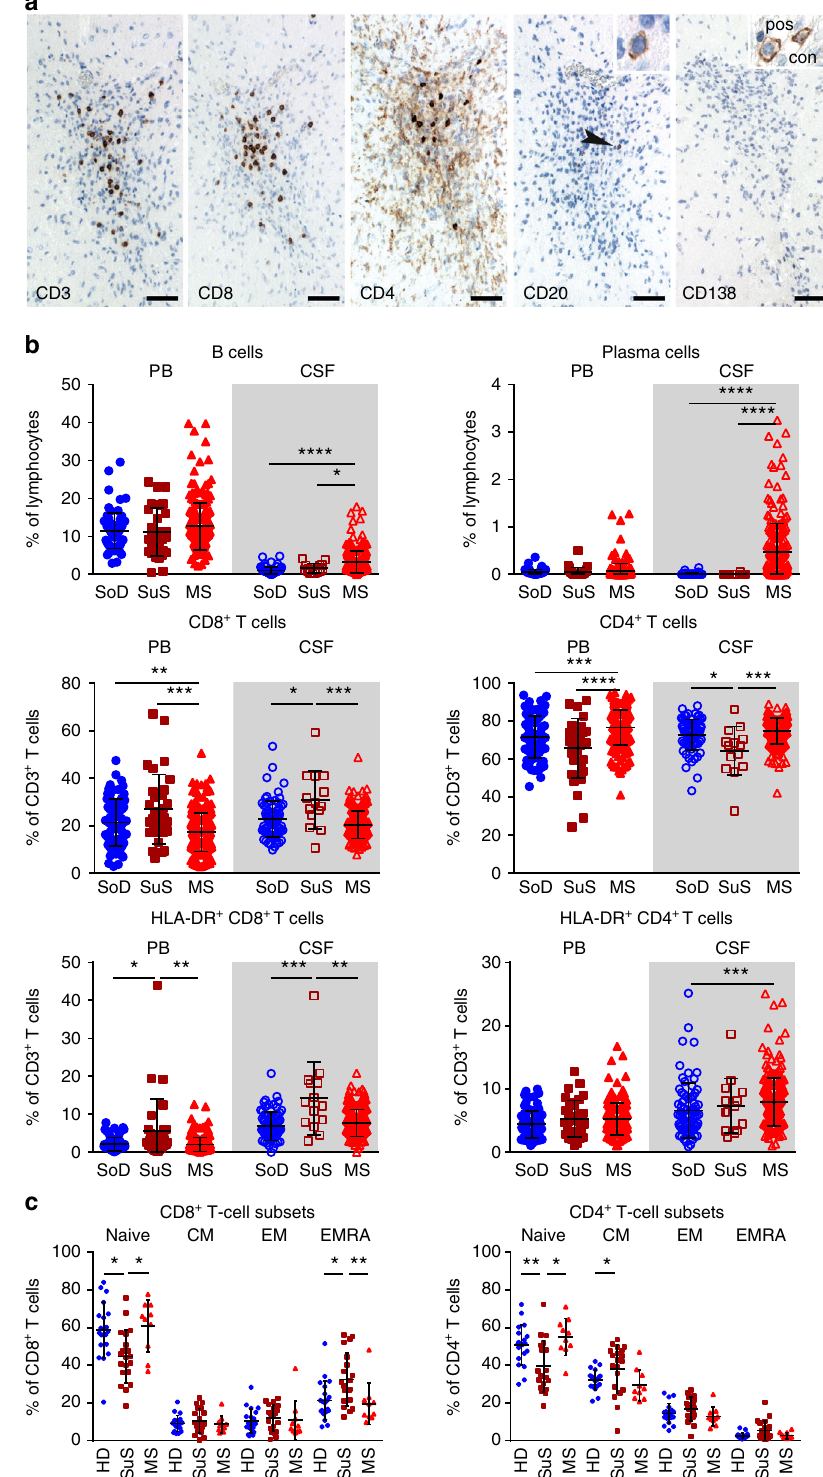
CD8 + T cells were con fi rmed (Fig. 2b, c). Notably, clonality signi fi cantly correlated with proportions of CD8 + T EMRA cells (Supplementary Fig. 4a) and accordingly highest clonality was observed in the CD8 + T EMRA repertoire (Fig. 2b, c), both in treatment-naive and corticosteroid-treated patients (Supplemen- tary Fig. 4b). Moreover, while the overall CD8 + T cell repertoire was clonally diverse, the CD8 + T EMRA repertoire was clearly